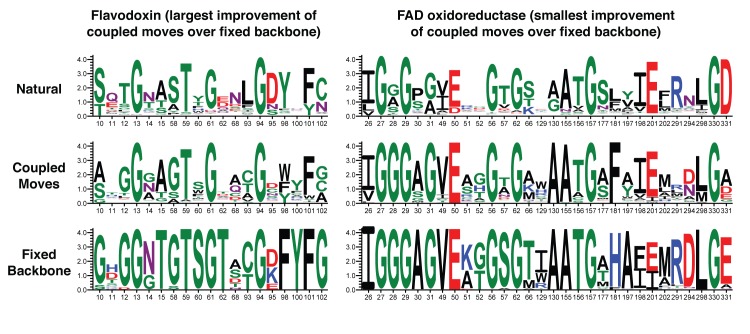
Sequence logos for predicted and naturally occurring binding site sequences.Two representative examples showing the largest (left) and the smallest (right) improvement of coupled moves (middle row) over fixed backbone design (bottom row) with respect to profile similarity with natural sequences (top row). The height of the letter representing each amino acid corresponds to its frequency and the height of each column is inversely proportional to the sequence variation at that position.